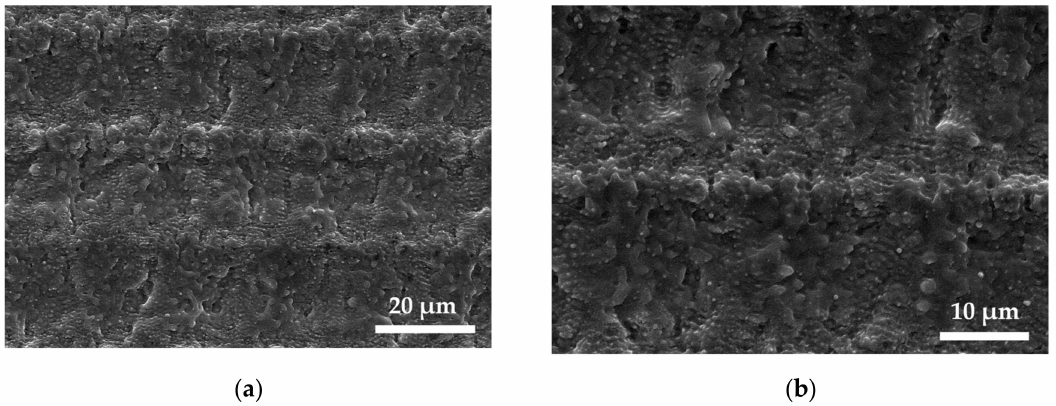
Figure 1. SEM images of structured Ti6Al4V surface with a laser pulse overlap of 50% and scanning line overlap of 40% at a fluence of q = 4.91 J / cm 2 . ( a ) A clear formation of trenches and ridges can be observed as a result of a low scanning line overlap ( b )